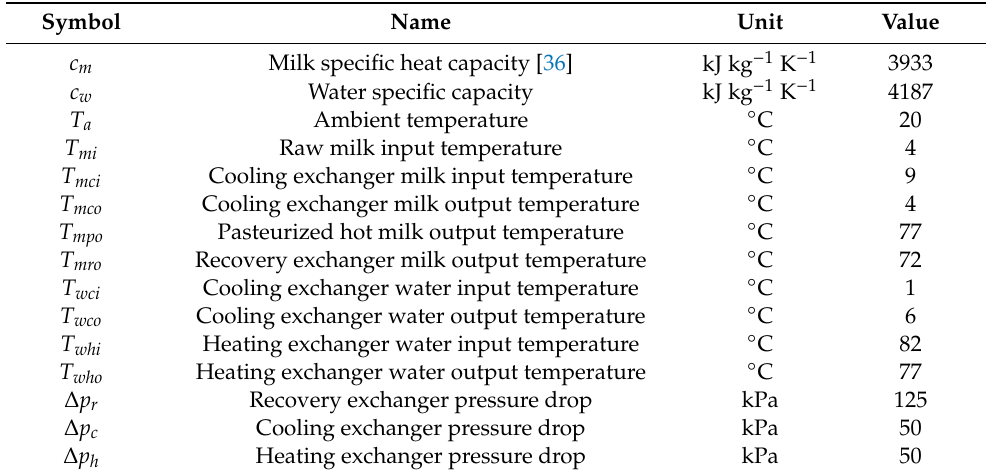
Table 1. Technical characteristics of pasteurization process used in the exergetic analysis, detected during the survey on the Italian dairies sample.